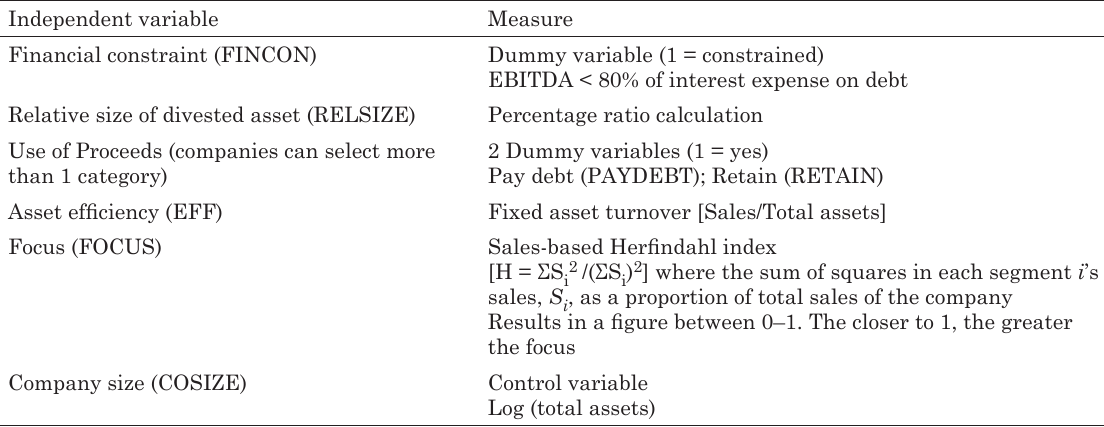
Table 1. Independent variables